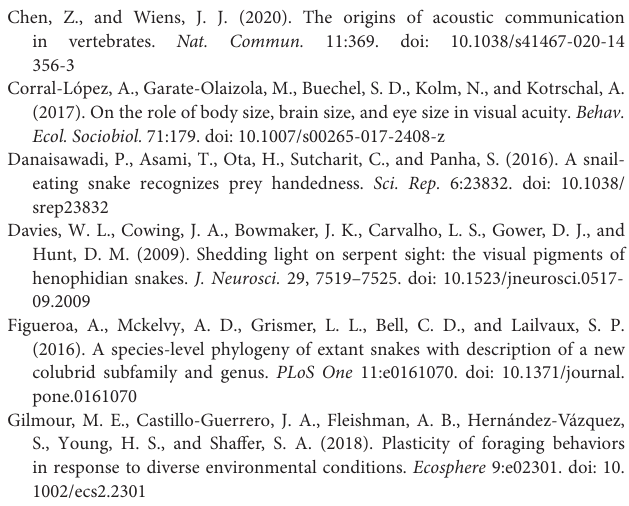
Supplementary Figure 1 | The measurement of snake eye diameter (A) and head width (B) . Supplementary Figure 2 | The most approximate relatives of 31 snake species from Taiwan used in this study. The phylogenetic tree is adapted from Figueroa et al. (2016) based on the most approximate phylogenetic tree. The numbers to the right of the nodes indicate the support of the bootstrap method. Red texts indicate that species in this study could not be matched with Figueroa et al. (2016) and should be synonyms. Blue texts indicate species were not included in Figueroa et al. (2016), so they are represented by similar